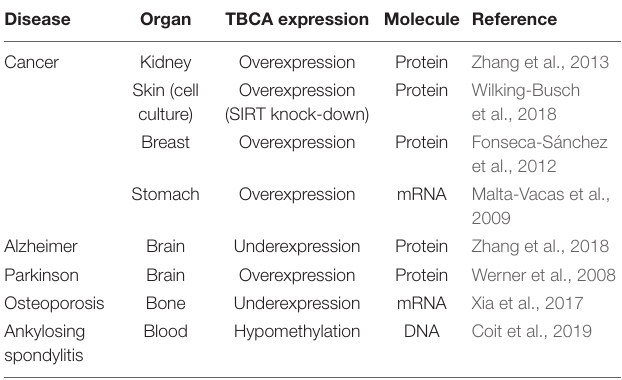
TABLE 1 | Altered TBCA expression in several diseases.